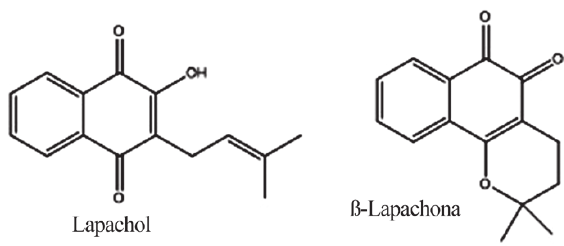
Figure 2 - Chemical structure of lapachol and β- lapachone.